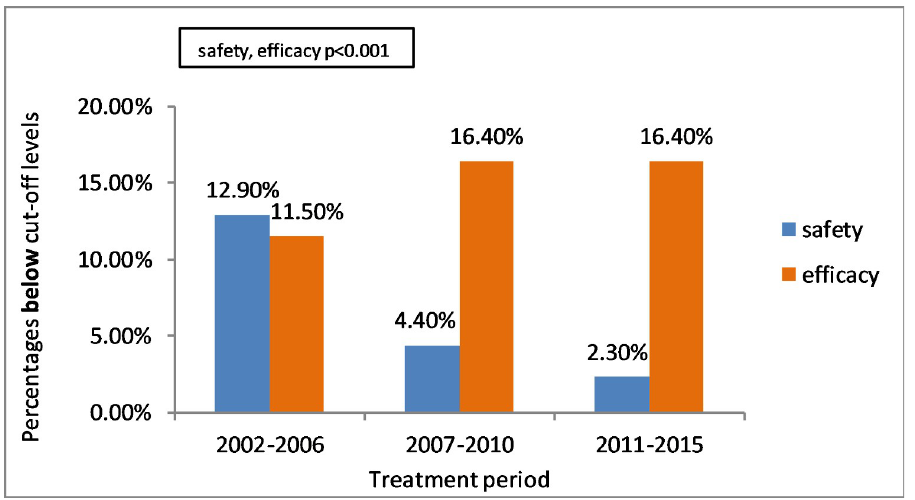
Fig 3. Association between treatment period and patients below safety and efficacy cut-off levels using univariate analysis and Pearson Chi-Square test (p < 0.001 for both safety and efficacy).